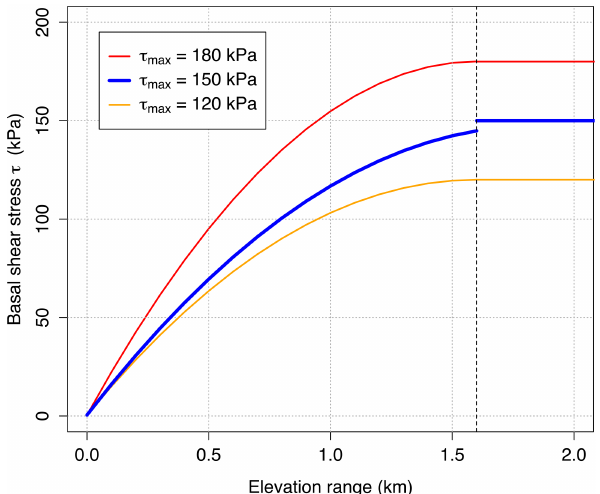
Figure 4. Parameterizations of the basal shear-stress τ with the elevation extent of the glacier. The blue line ( τ max = 150kPa) corresponds to the original parameterization from Haeberli and Hoelzle (1995), the modified parameterizations ( τ max ± 30kPa) are shown in red and